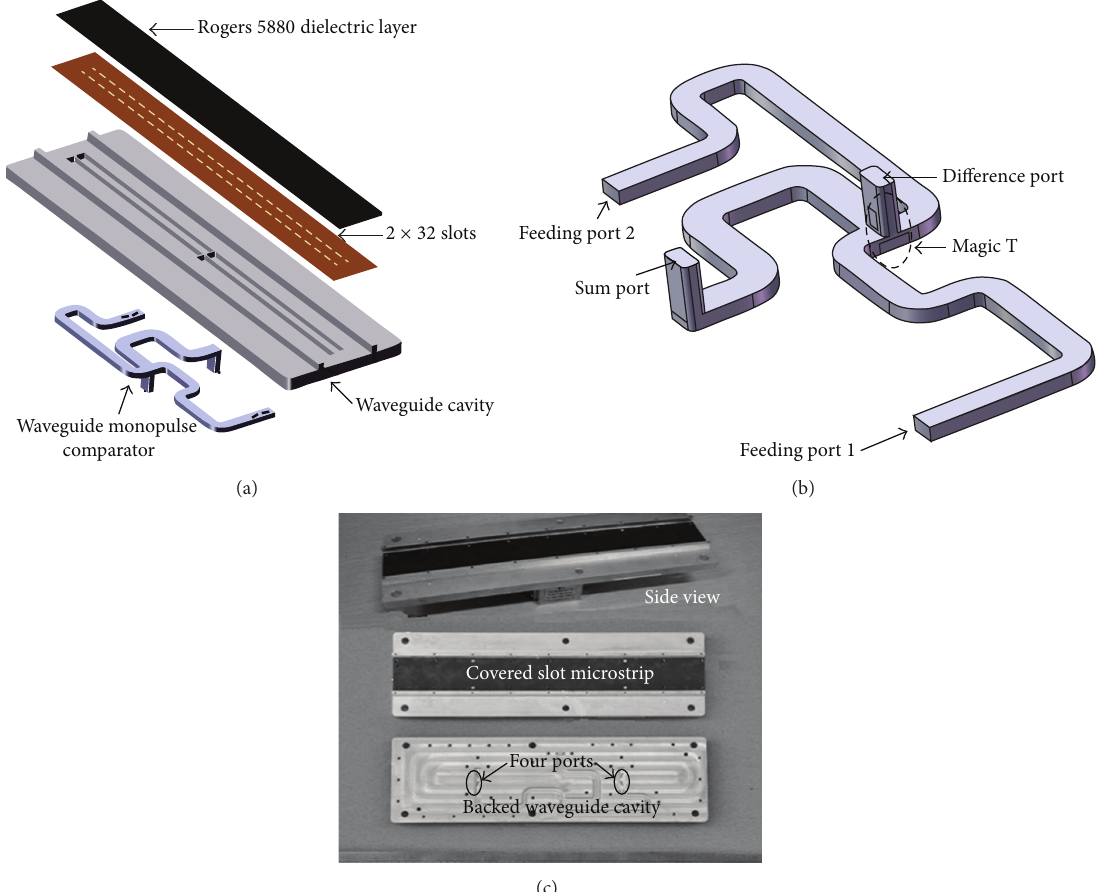
Figure 1: Structure of the monopulse antenna array. (a) Exploded view, (b) waveguide monopulse comparator, and (c)